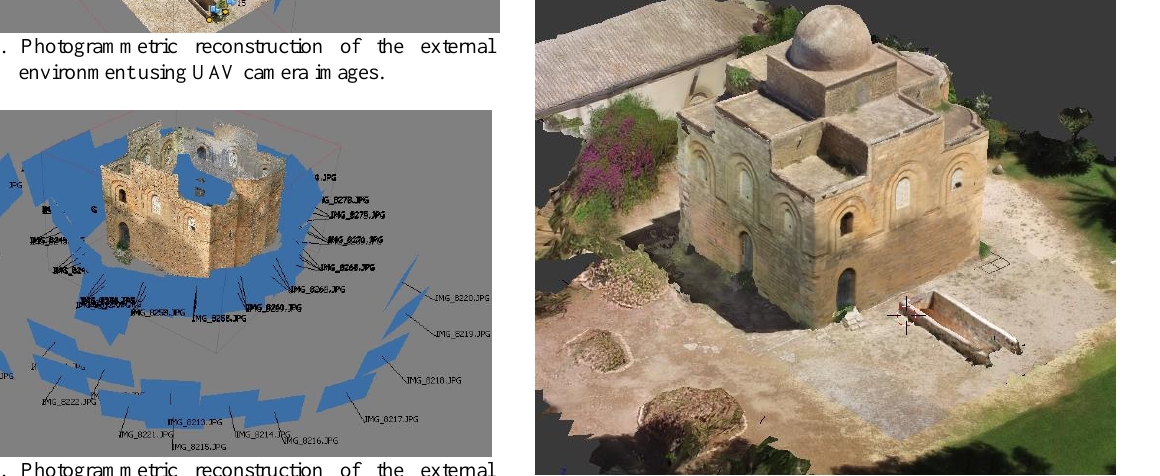
Figure 9. The 3D mesh of the external model in